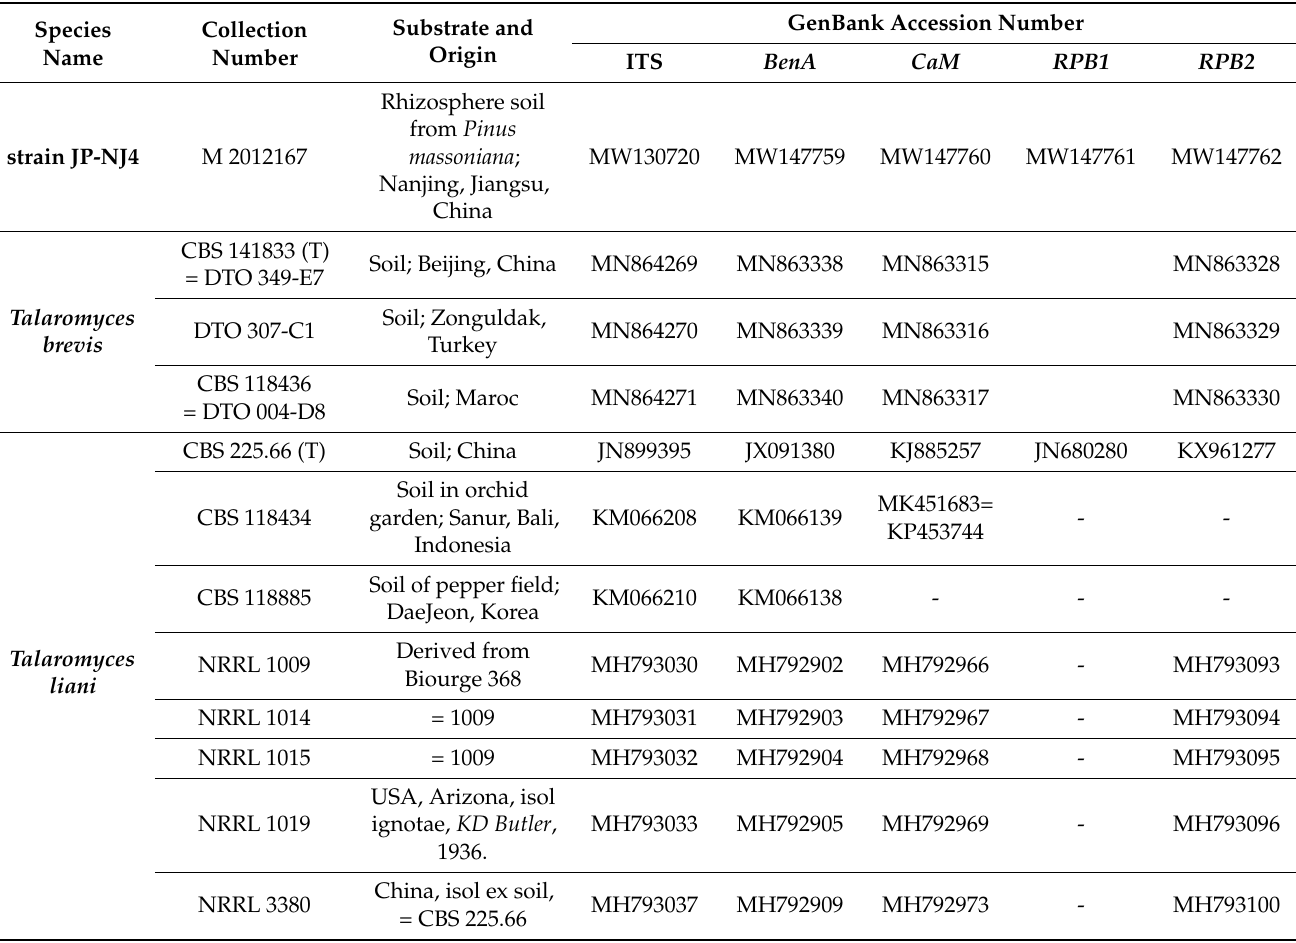
Table 1. Collection numbers of strains, isolation details and GenBank accession numbers of the five genes/region used for phylogenetic analysis of the strain